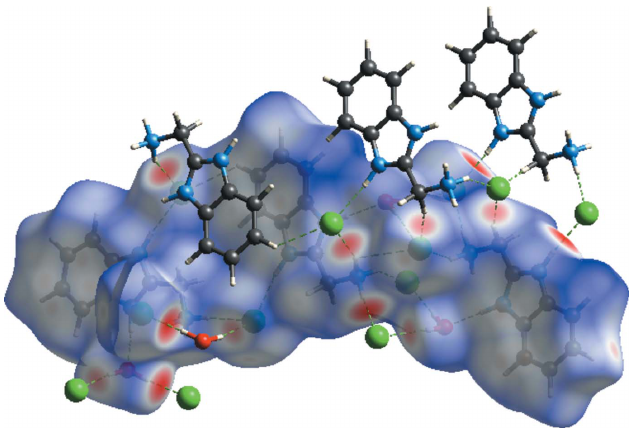
Figure 4 Hirshfeld surface mapped over d norm to visualize the intermolecular interactions of the title